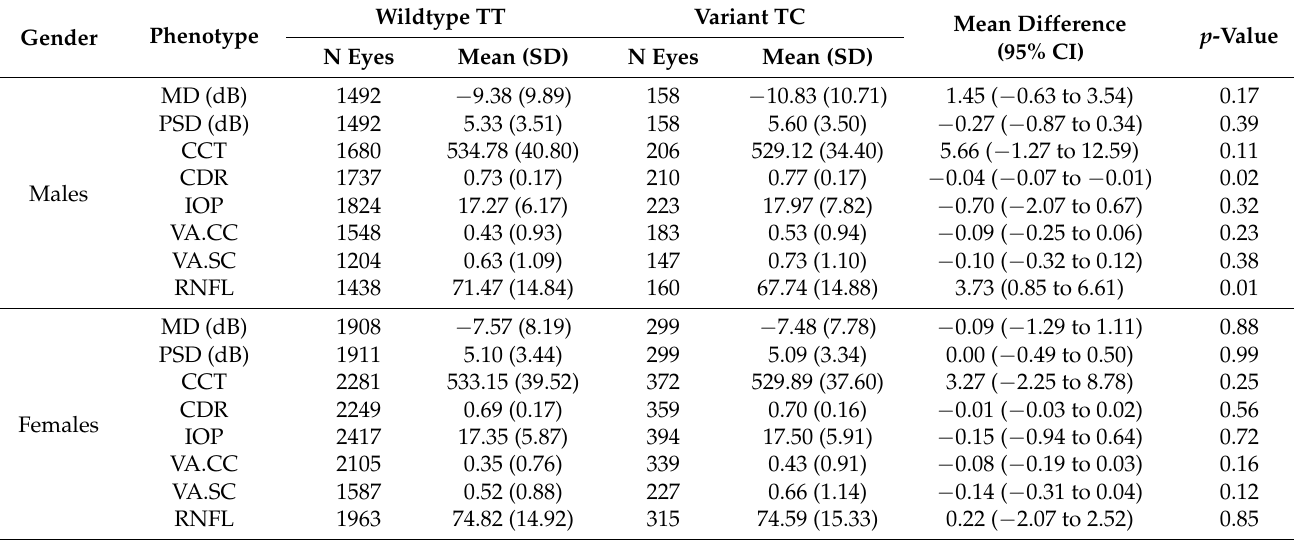
Table 3. Association of TRIM66 rs112369934 in our measured quantitative phenotypes in gender stratified